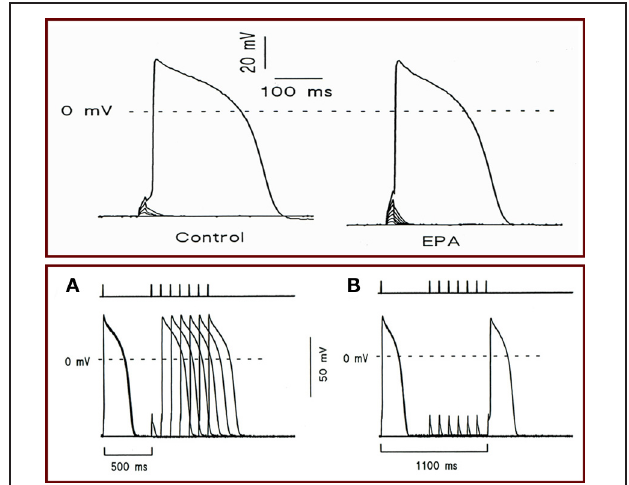
FIGURE 3 | (Top panel) Effect of EPA on holding voltage at constant imposed current, threshold voltage, and current required to attain action-potential threshold. Holding potential was initially set at − 70mV, and cells were stimulated with a series of depolarization pulses in 3- or 4-pA increment at 10s intervals. Recordings showing the holding transmembrane potentials, the threshold potentials, and the currents required to elicit an action potential in a cell before (Left) and after (Right) exposure to 10 µ M EPA. (Bottom panel) The effect of EPA on the cycle length of excitability. Cells were given a pair of superthreshold electrical stimuli at 0.1Hz (necessary to elicit action potential in the presence of EPA) with various intervals from 500 to 1500ms in 100ms increments. Bars at top indicate the time intervals between two stimuli. (A) Recording showing the cycle length (600ms) before 10 µ M EPA exposure. (B) Recording showing cycle length (1100ms) 3min after EPA